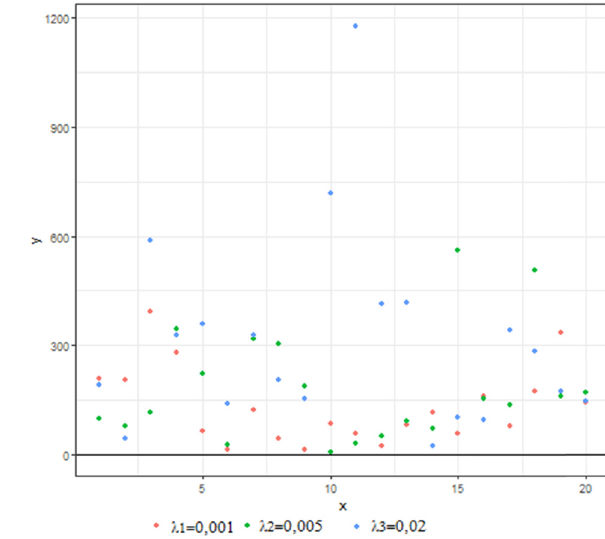
Figure 1: Simulation of transition between states in T = 1,000 conse - Figure 3: Simulation of times for the parameters of the exponential cutive moments of time ( starting from state 0 – no pending reports ) , for distribution μ = 0.008 and λ 1 = 0.001, λ 2 = 0.005, and λ 3 = 0.02 of the presence of reports in the system for 20 randomly generated reports. (cid:129) with a set intensity of reports λ = 0,005 and three dif - = 0.003, μ = 0.008, ferent service intensity values μ 1 2